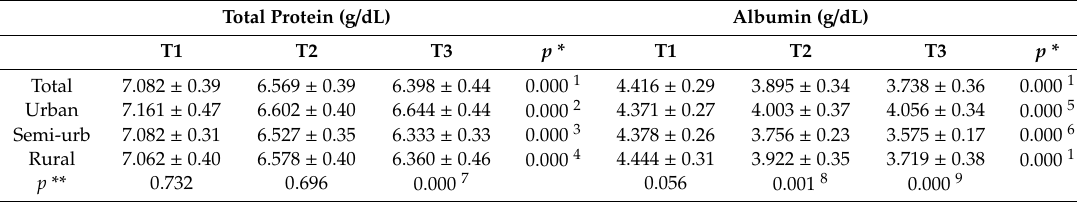
Table 2. Plasma total protein and albumin levels in women included in the